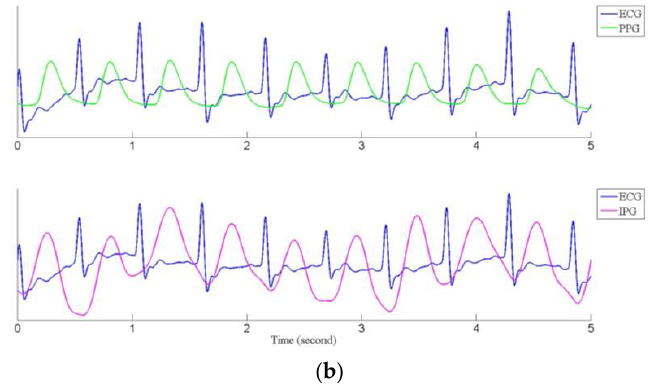
Figure 9. The ECG (blue), PPG (green) and IPG (purple) signals, ( a ) before exercise; ( b ) after exercise.